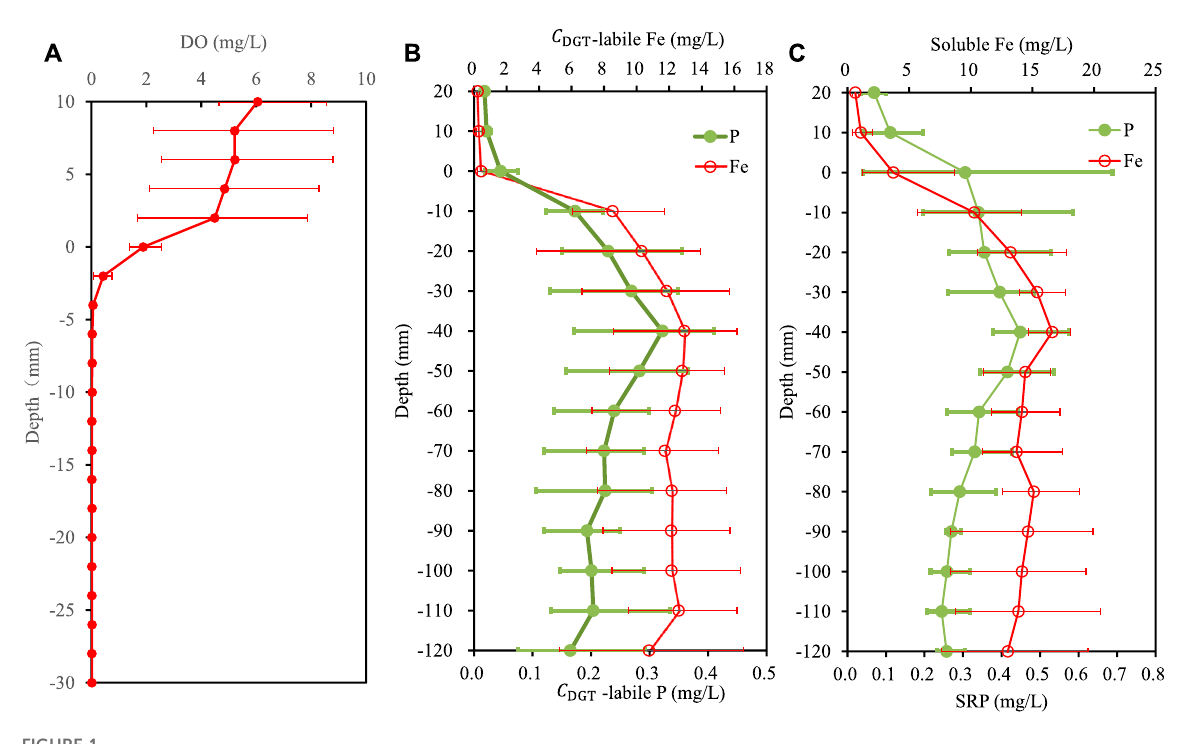
FIGURE 1 Distribution of the vertical concentrations in paddy soils. (A) DO concentrations, (B) DGT-labile P and DGT-labile Fe concentrations, and (C) pore water SRP and soluble Fe concentrations. Error bars indicate ± standard deviation of the mean (n